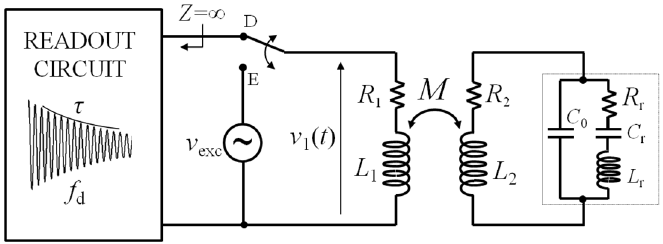
Figure 9. Block diagram of the time-gated technique applied to a coil-coupled electromechanical piezoelectric resonator.